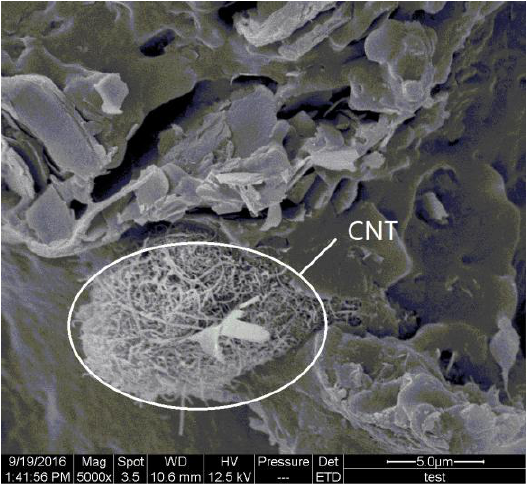
Figure 9. The agglomeration of CNTs in the 0.15% CNT/WPCs part by SLS.